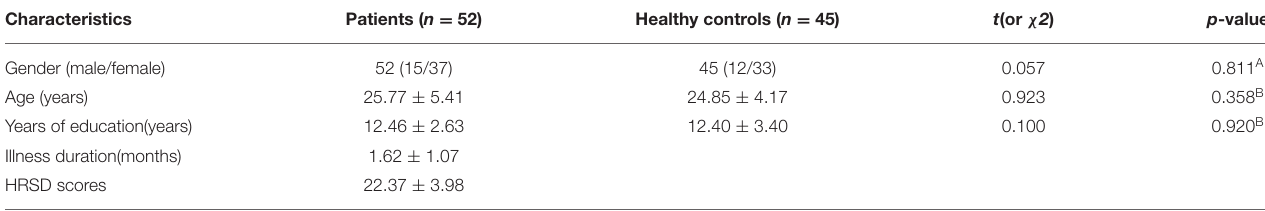
TABLE 1 | Clinical information of the participants. Characteristics